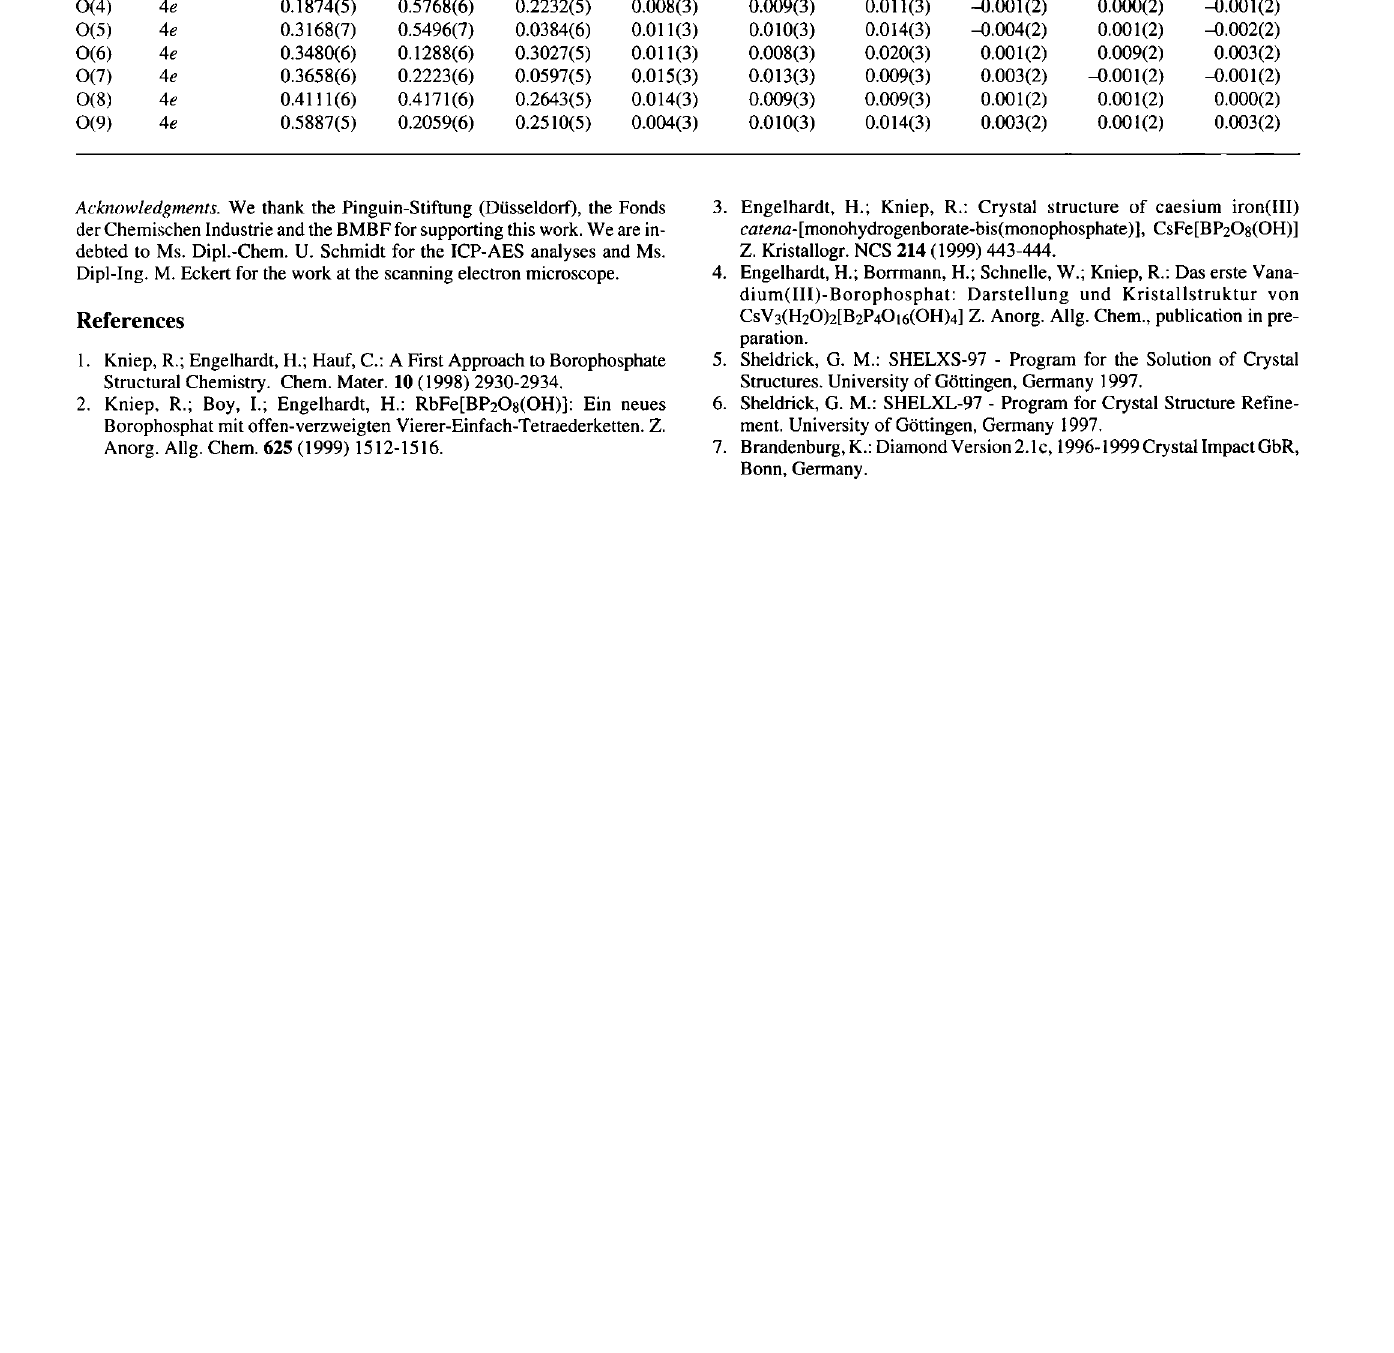
Table 3. Atomic coordinates and displacement parameters (in Ä 2